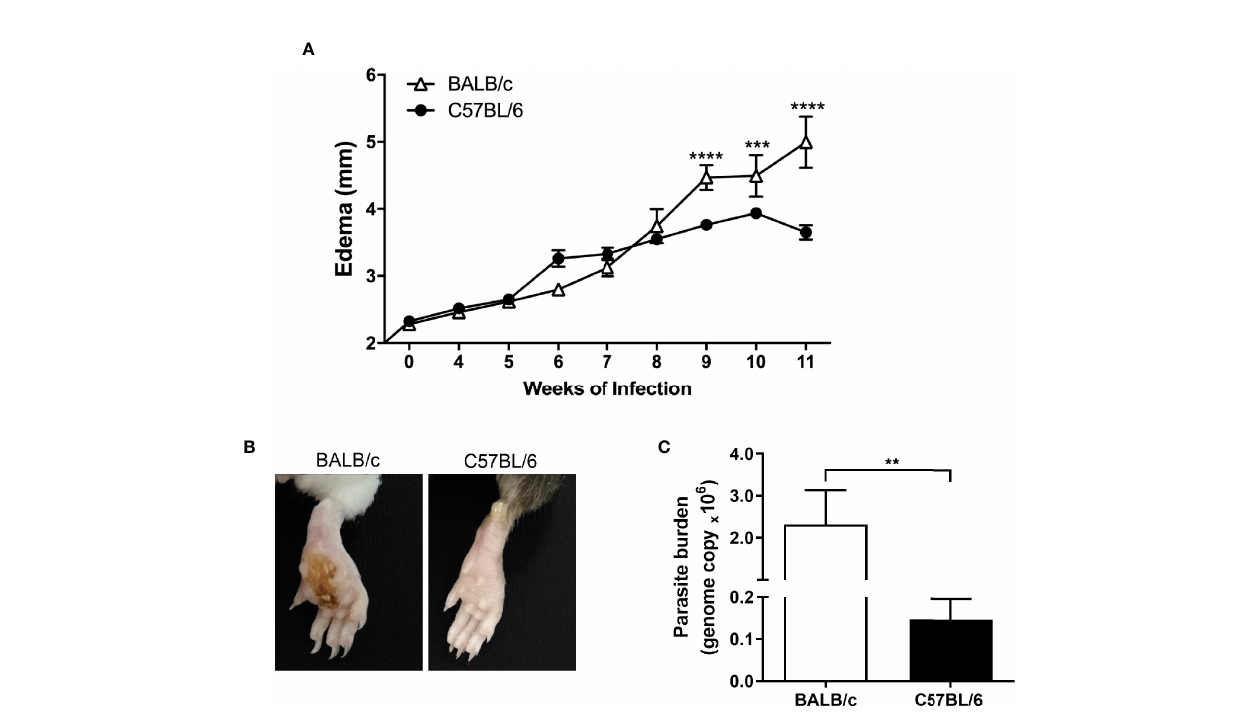
FIGURE 1 | Evolution of L. amazonensis infection in BALB/c and C57BL/6 mice. (A) BALB/c and C57BL/6 mice were infected on the hind paws with 10 5 promastigote forms of L. amazonensis /paw, and the edema was analyzed for 11 weeks. (B) Representative images of BALB/c and C57BL/6 mice paws 11 weeks after the infection with L. amazonensis . (C) Parasitic load (number of Leishmania amazonensis kDNA copies) determined in the mouse paw homogenate by quantitative real-time PCR after 11 weeks of infection. Data represent the mean ± SEM of six mice groups. **Signi fi cant difference in relation to the opposite strain infected by L. amazonensis , p ≤ 0.01, ***p ≤ 0.001, ****p ≤ 0.0001.